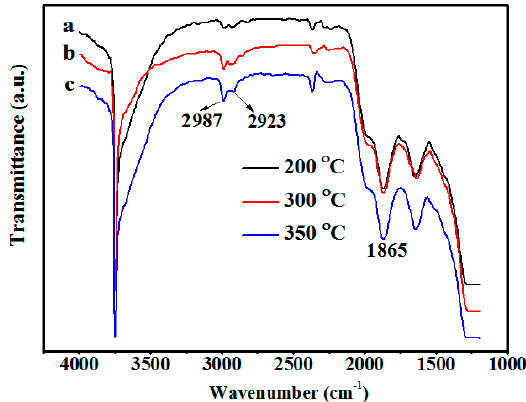
Figure 1. IR spectra of dehydrated silica after interaction with saturated vapors of diethyl carbonate at (a) 200 °C; (b) 300 °C; (c) 350 °C and subsequent vacuum treatment of the samples at the same temperatures.